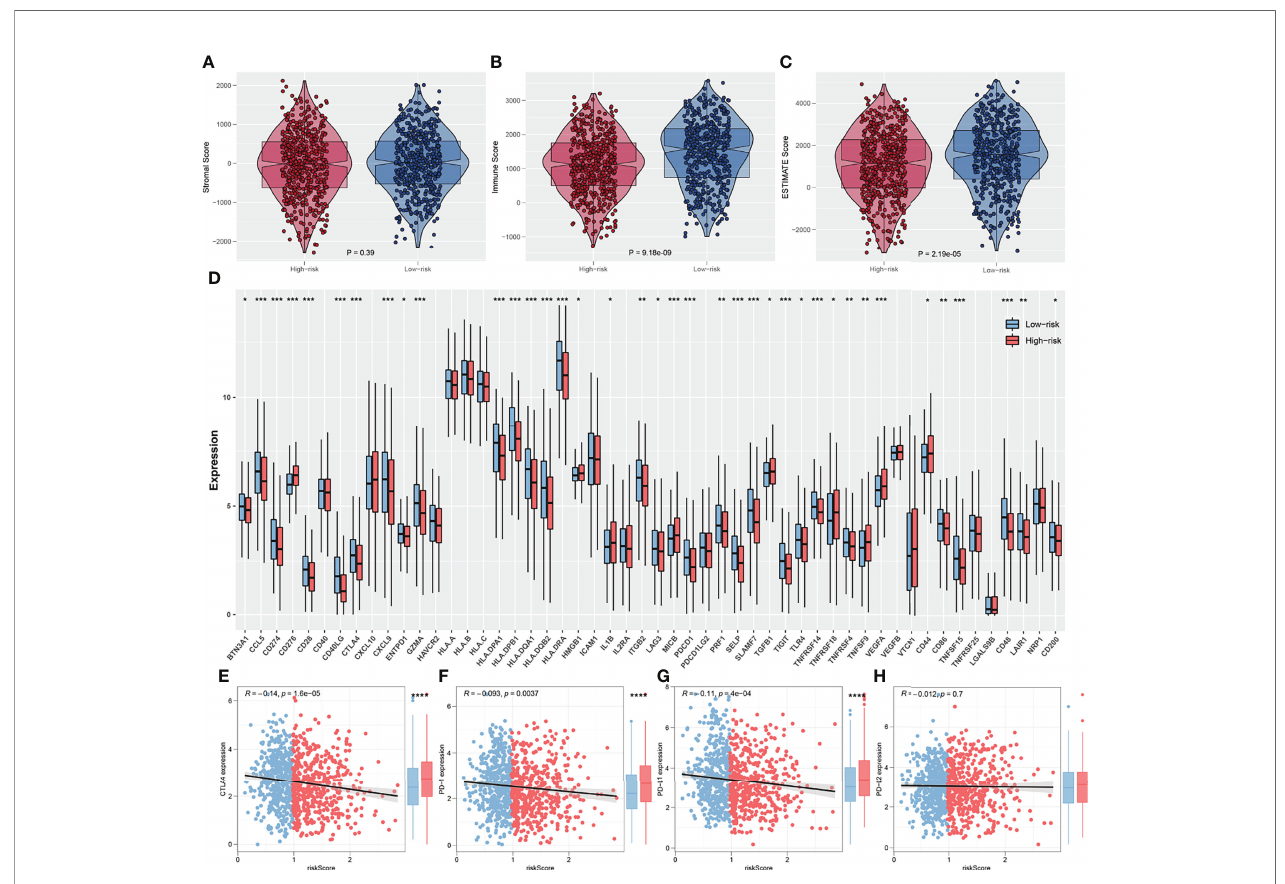
FIGURE 8 | Exploration of the association of immune checkpoint genes with IRS. (A – C) The stromalscore, immunescore and estimatescore difference between high and low IRS group; (D) Signi fi cant differences were observed in multiple immune checkpoint genes between high and low IRS groups; (E – H) The difference of serval important immune checkpoint in high and low IRS patients. *P < 0.05, **P < 0.01, ***P <